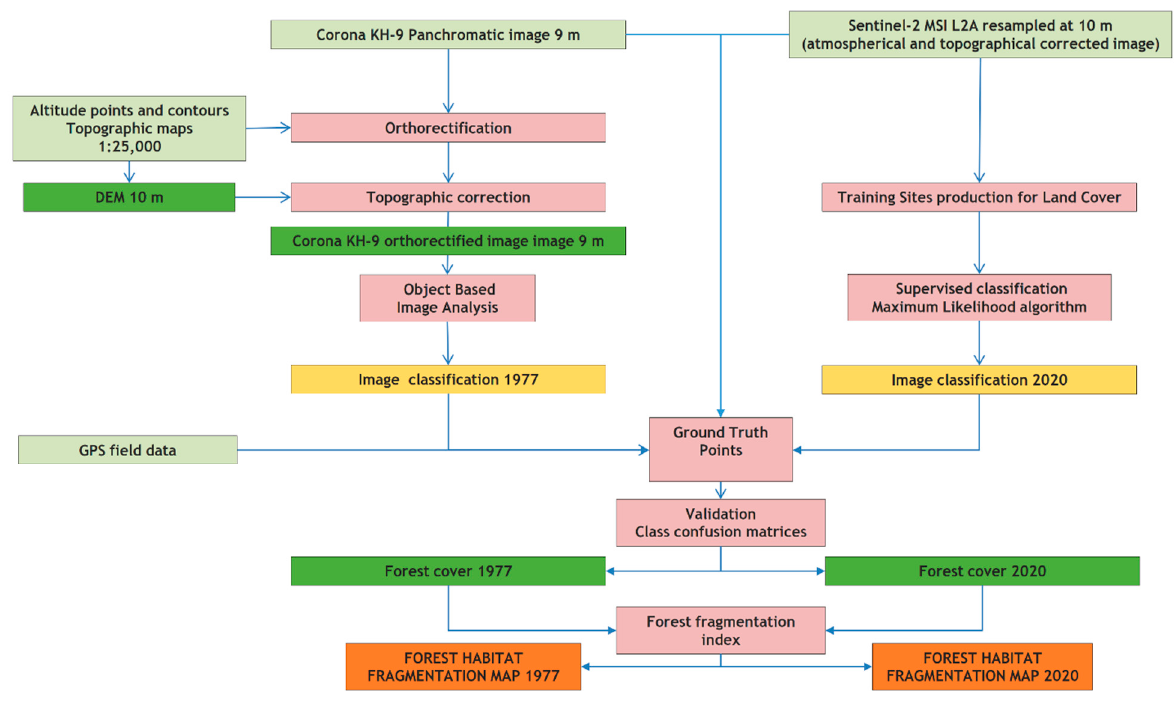
Figure 4. Workflow of the analysis.